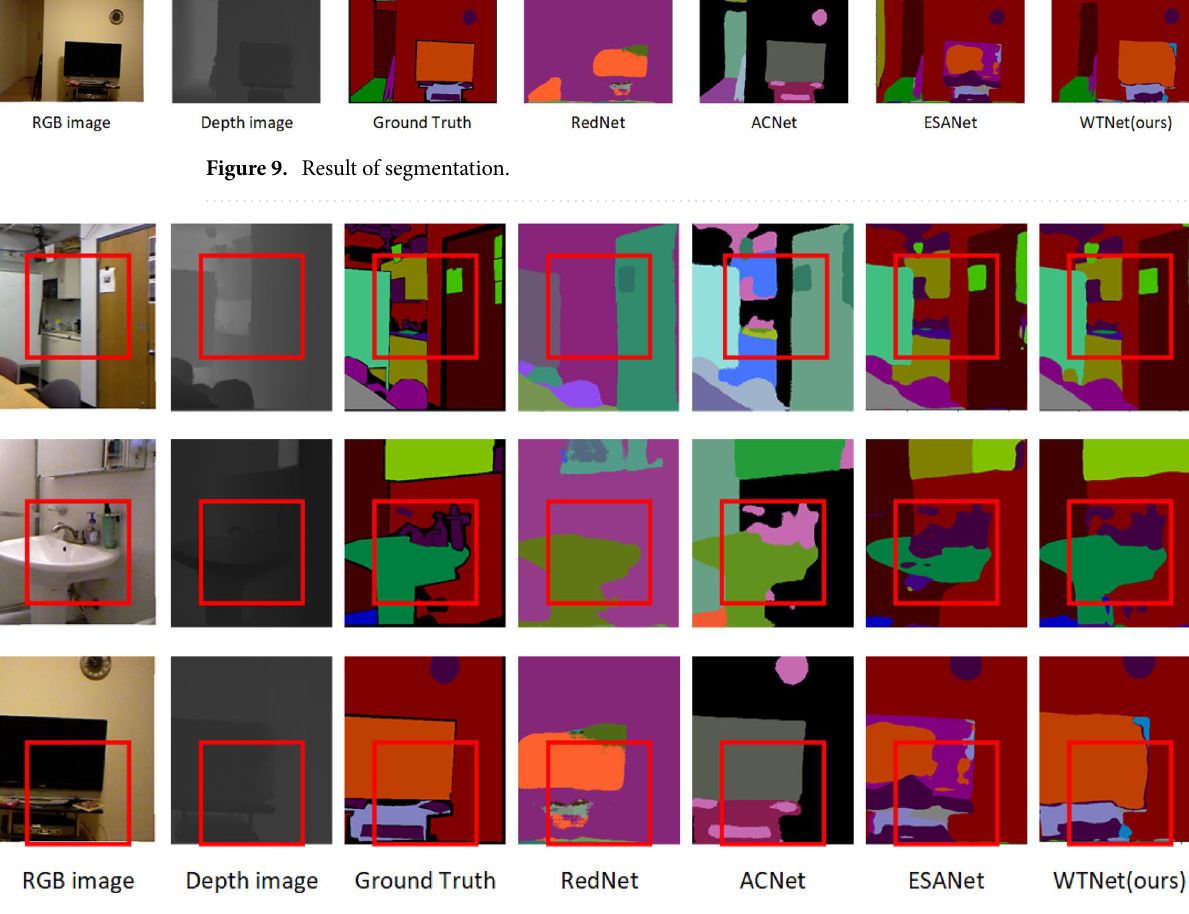
Figure 10. Detail of Segmentation